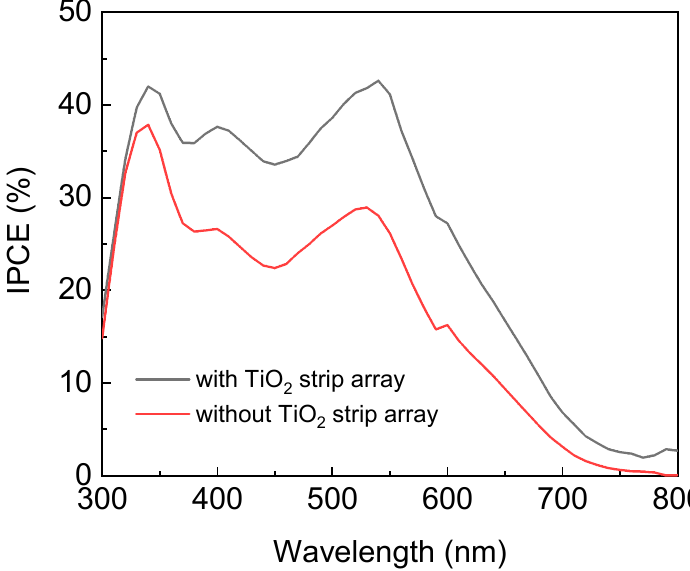
Figure 6. IPCE spectra of DSSCs with and without a TiO 2 strip array. The electrochemical impedance spectra of the DSSCs with and without the TiO 2 strip array were measured using a potentiostat/galvanostat (WonATech, ZIVE SP1, Seoul, Korea) at a solar intensity of 100 mW/cm 2 and bias voltage of 10 mV, and the frequency in the measurement ranged from 10 mHz to 1 MHz. Figure 7a,b present the Nyquist and Bode plots of the DSSCs with and without TiO 2 strip array. The plots were obtained from the electrochemical impedance spectra of the DSSCs with and without the TiO 2 strip array. with TiO 2 strip array without TiO 2 strip array